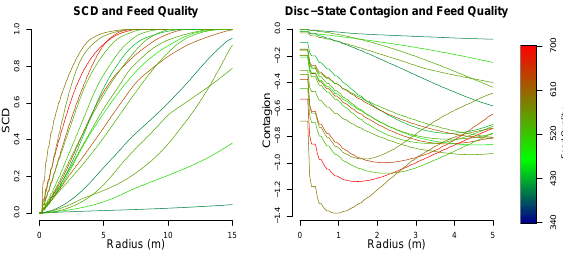
Figure 6: Conditional SCD (left) and disc-state contagion (right). Curves are coloured by feed quality. There is no discernible pattern of high feed quality processes.